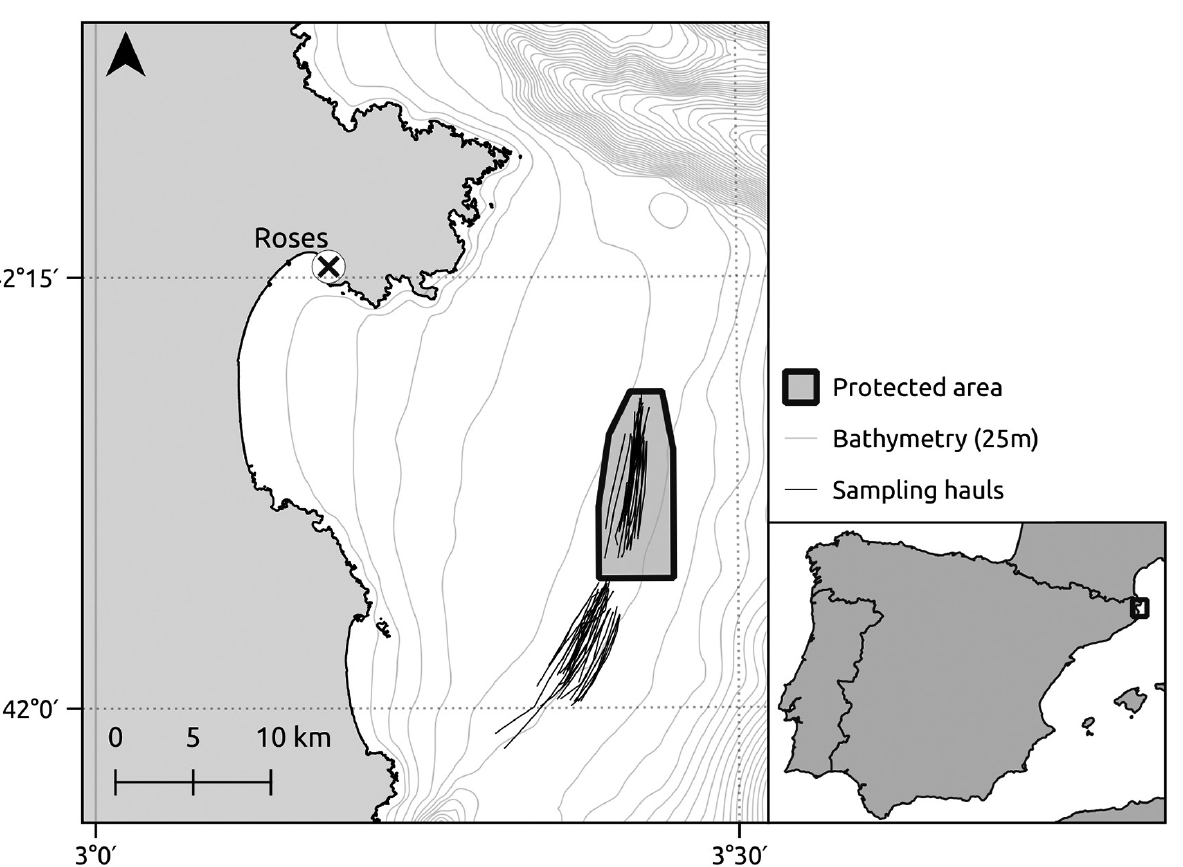
Fig. 1. – Location of the study area (Gulf of Roses, Catalonia, Spain), with indication of the no-take area (closed polygon) and the area open to the fishery. Bathymetry lines in 25 m